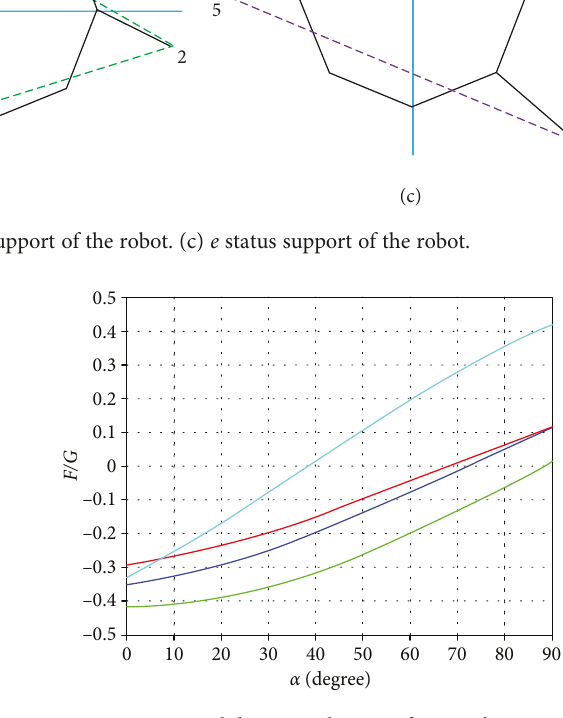
Figure 10: Instability critical curve of triangular